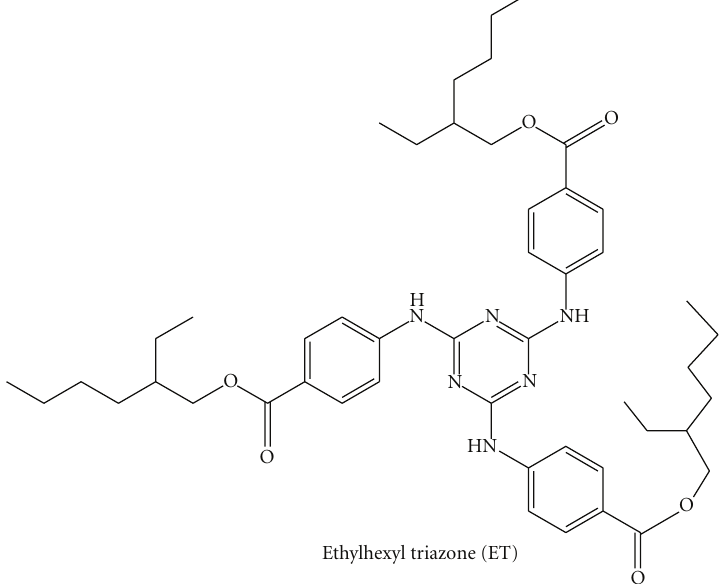
Figure 1: Structural formula of